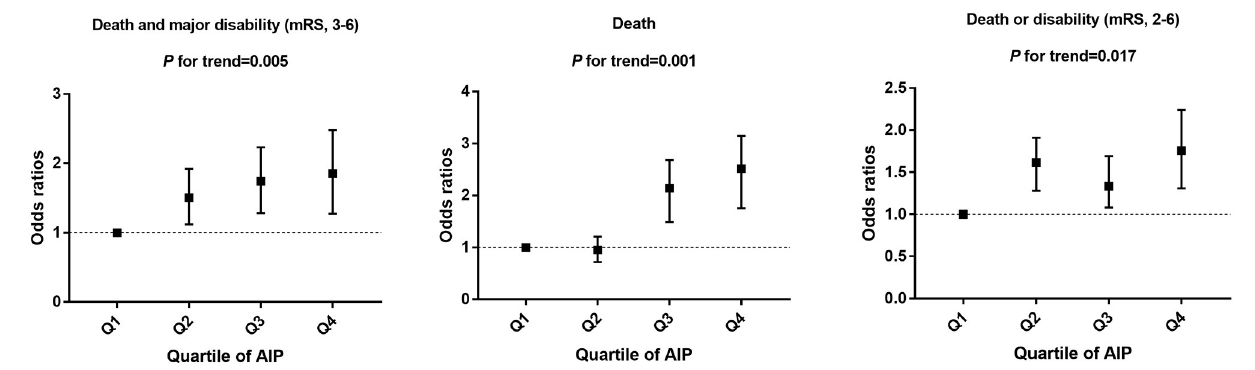
FIGURE 2 | Multivariable adjusted odds ratios for functional outcomes, grouped by AIP quartile in patients. (sensitivity 72.7% and specificity 64.6%), and 0.116 in disability (sensitivity 77.3% and specificity 61.5%). The positive/negative likelihood ratios and diagnostic odds ratio for each predictive marker are shown in Supplementary Table 3